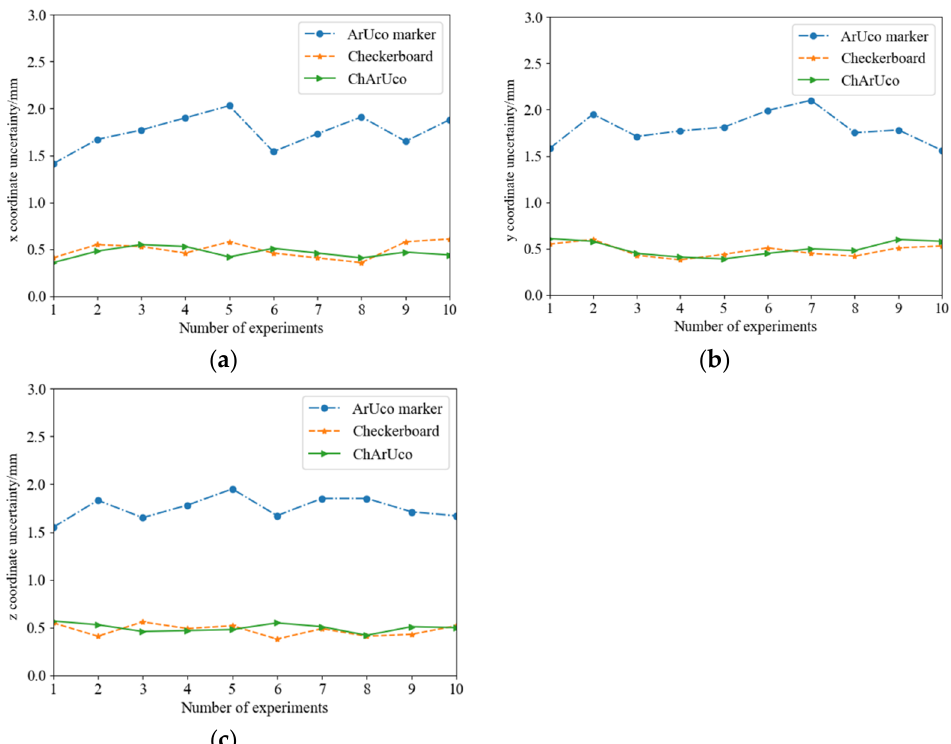
Figure 11. Hand–eye calibration uncertainty: ( a ) x coordinate reprojection uncertainty; ( b ) y coordi- nate reprojection uncertainty; and ( c ) z coordinate reprojection uncertainty .